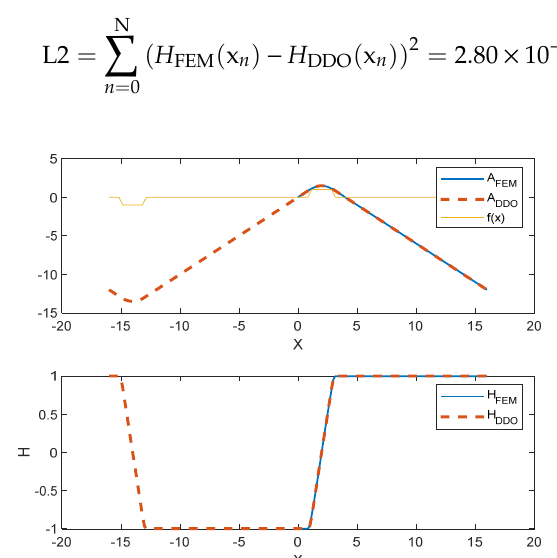
Figure 7. Vector potential and magnetic field solutions of the finite element method (FEM) and discrete difference operator (DDO).